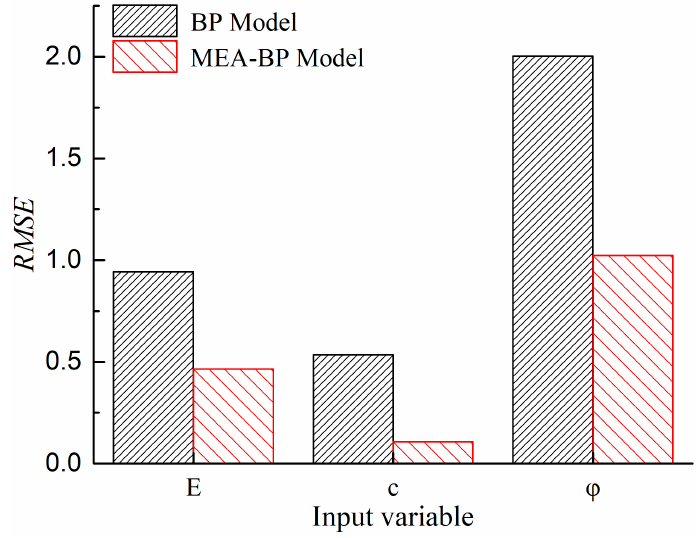
Figure 9. The variation of RMSE for three predicted variables.